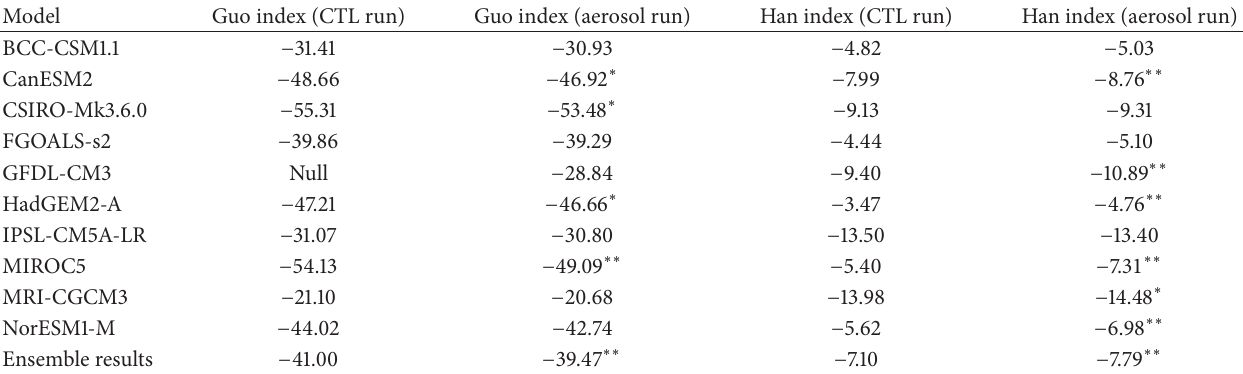
Table 2: The EASMI calculated by the Guo and Han indices in the CTL and aerosol runs.